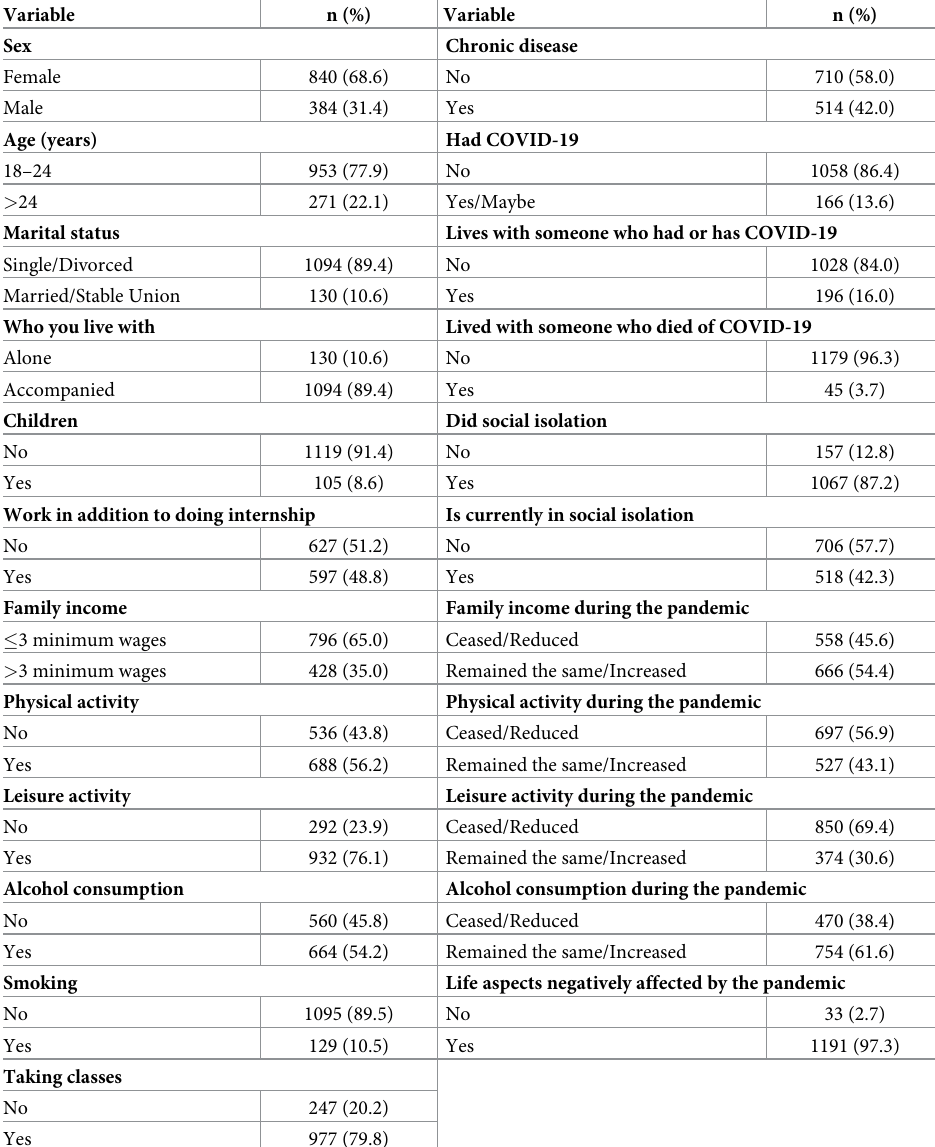
Table 1. Characterization of the socioeconomic, health, academic profile and the impact of the COVID-19 pan- demic on undergraduate students, Parana, Brazil, 2020. Variable n (%) Variable n (%) Sex Chronic